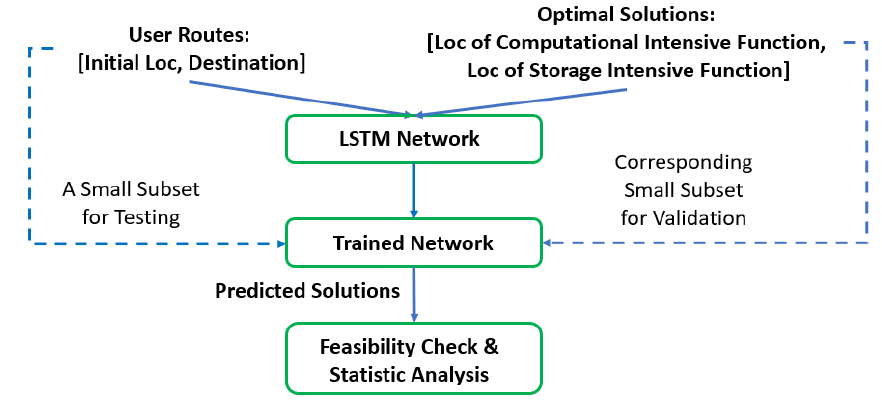
Figure 3. Working Process of the LSTM-based Model.